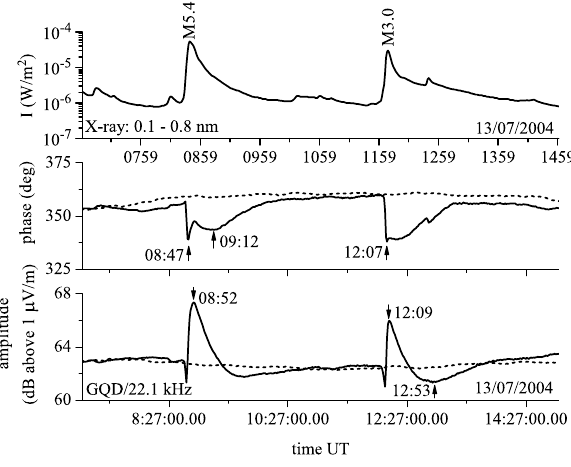
Fig. 6. Simultaneous variation of X-ray irradiance and GQD signal phase and amplitude during M5.4 (08:48UT) and M3.0 (12:08UT) events on 13 July 2004 – solid lines. Extrema indicated by arrows and the corresponding UT. Phase and amplitude on the quiet day 8 July 2005 – dashed